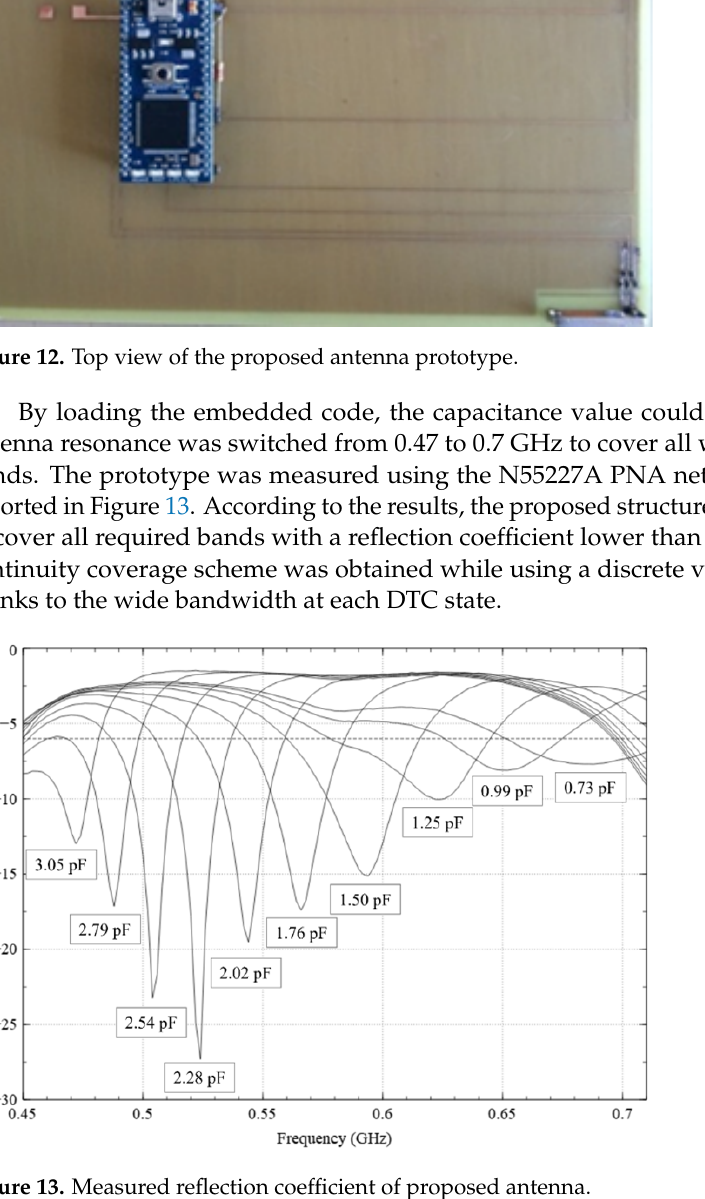
Figure 13. Measured reflection coefficient of proposed